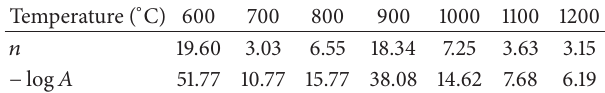
Figure 4: SQUAT test facility. Table 2: Norton law coefficients of MECTUB